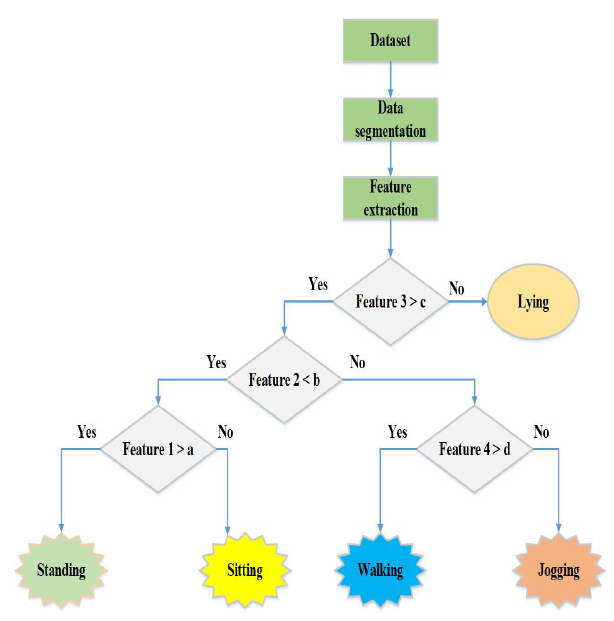
Fig 12. Activities might be easily recognized by the use of features. There was some confusion between the various activities in the moving state, though.